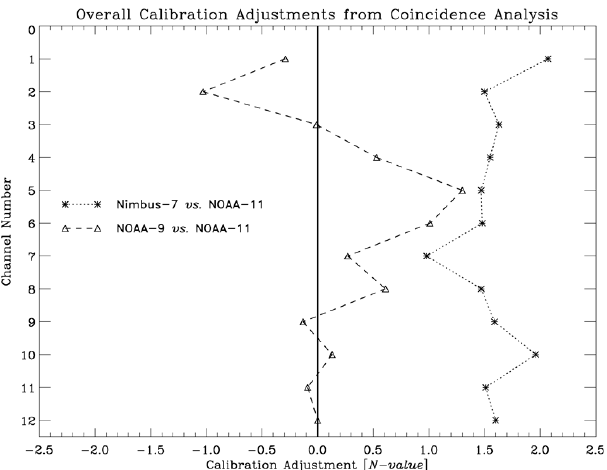
Fig. 10. Calculated intercalibration adjustments for NOAA-9 and Nimbus-7 relative to NOAA-11, based on coincidence comparisons at equatorial latitudes. Note that the Nimbus-7 adjustment also in- cludes a wavelength-independent adjustment of − 4% based on Antarctic snow/ice radiance